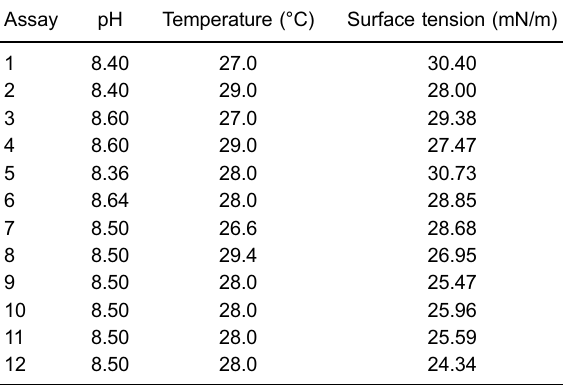
Table 2. Planning matrix for central composite rotational design of experimental data for the biosurfactant produced by Strepto-